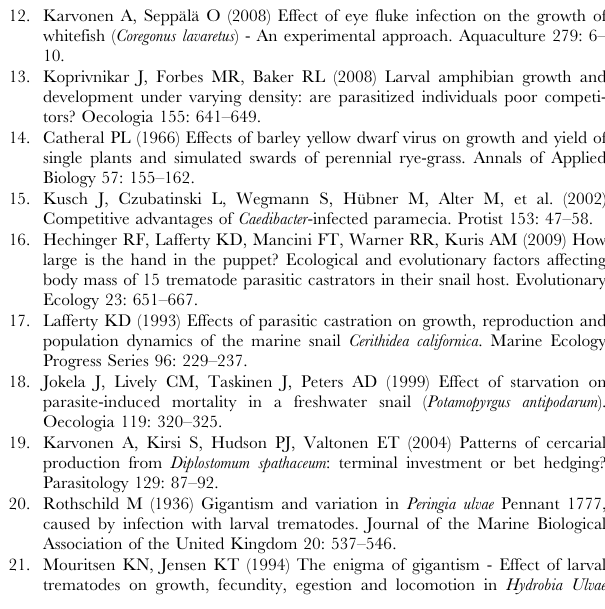
Figure S1 Change in shell length of Lymnaea stagnalis snails during the experiment. Error bars (mean 6 SE) show the size of focal individuals with different infection status [unexposed (white), exposed but unparasitized (grey), exposed and parasitized (black); parasite: Diplostomum pseudospathaceum ] maintained together with another snail individual [competitor; unexposed ( % ), exposed but unparasitized ( e ), exposed and parasitized ( # ); parasite: D. pseudospathaceum ] under (A) ad libitum food supply and (B) reduced food supply (i.e. half of the average food consumption). The snails were maintained ten weeks, and their size was measured in two- week-intervals.